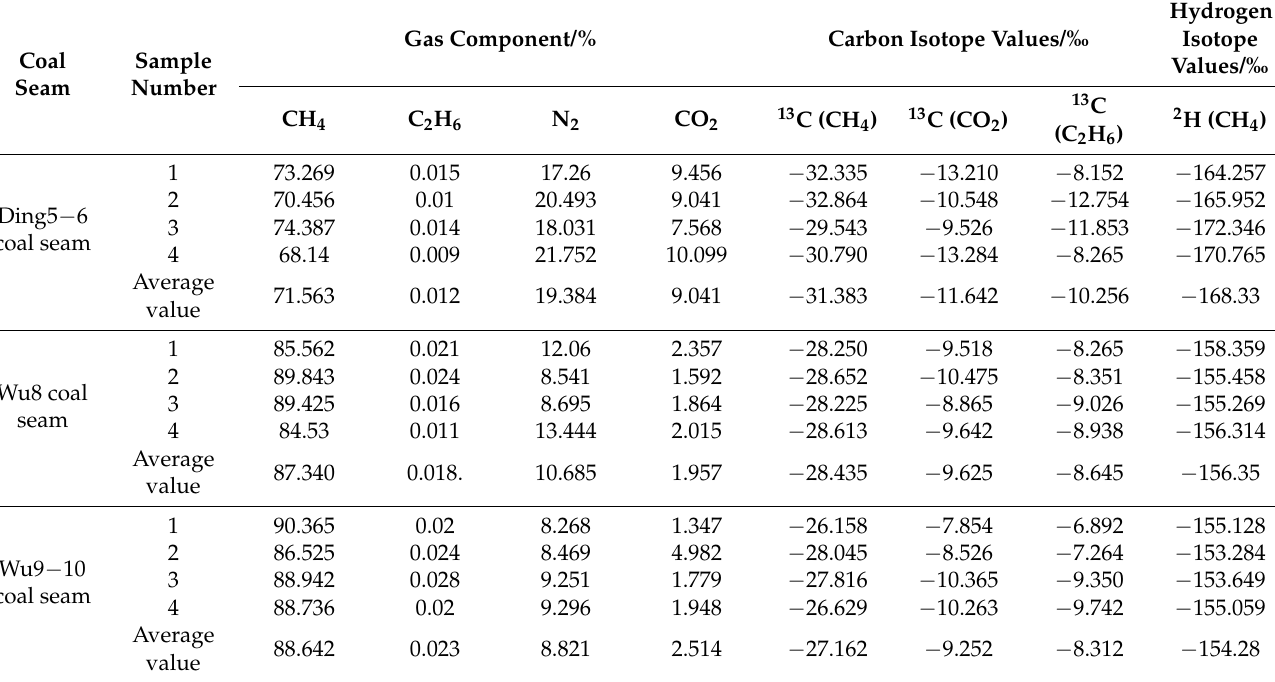
Table 1. Test results of gas components and hydrocarbon isotope values of each coal